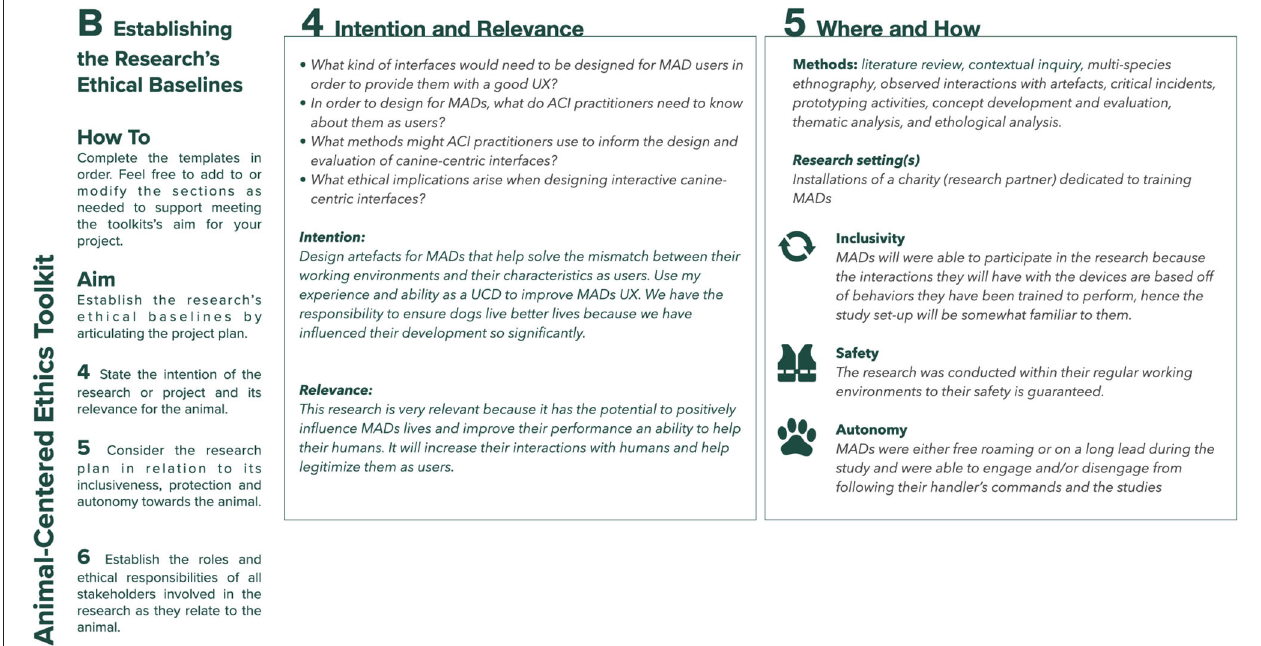
FIGURE 5 | Sample of template B: establishing the research’s ethical baselines for the design of a set of canine-centric controls for Mobility Assistance Dogs, steps 4 and 5.